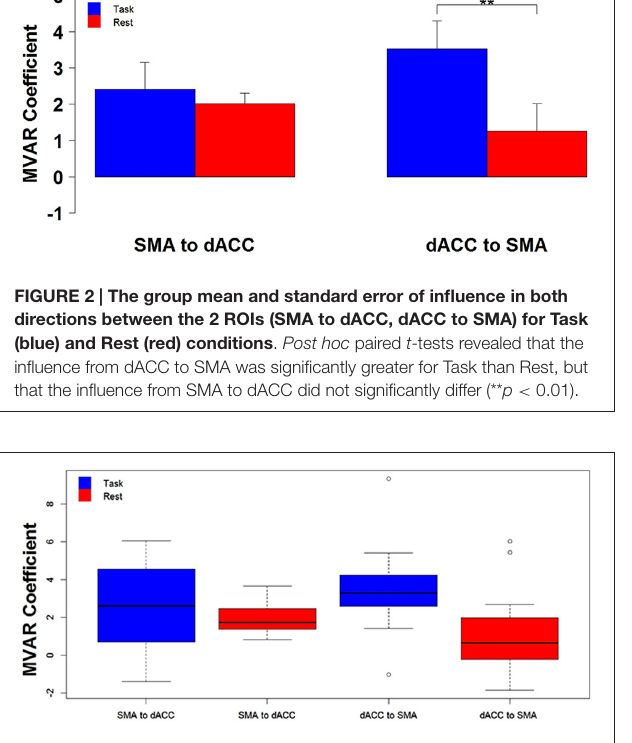
FIGURE 3 | The distribution across subjects for both directions between the 2 ROIs (SMA to dACC, dACC to SMA) and for Task (blue) and Rest (red) conditions, as box plots corresponding to the bar plots in Figure 2 . Note that the distribution for the influence from dACC to SMA during the Task is both more compact than and elevated above the distribution during